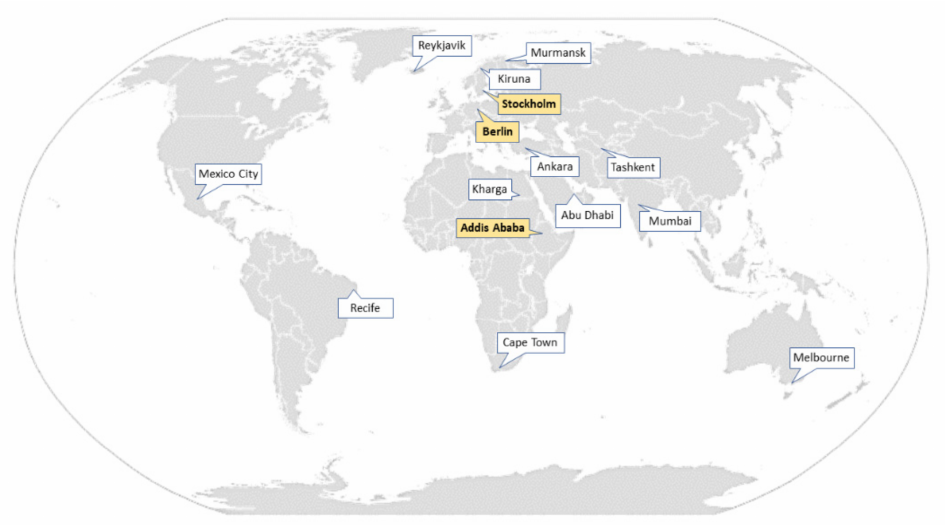
Figure 3. All selected representative locations on a world map. Yellow background color indicates the locations for detailed analysis. Table 1. The selected regions and the representative climate zones with data from ASHRAE 169– 2020